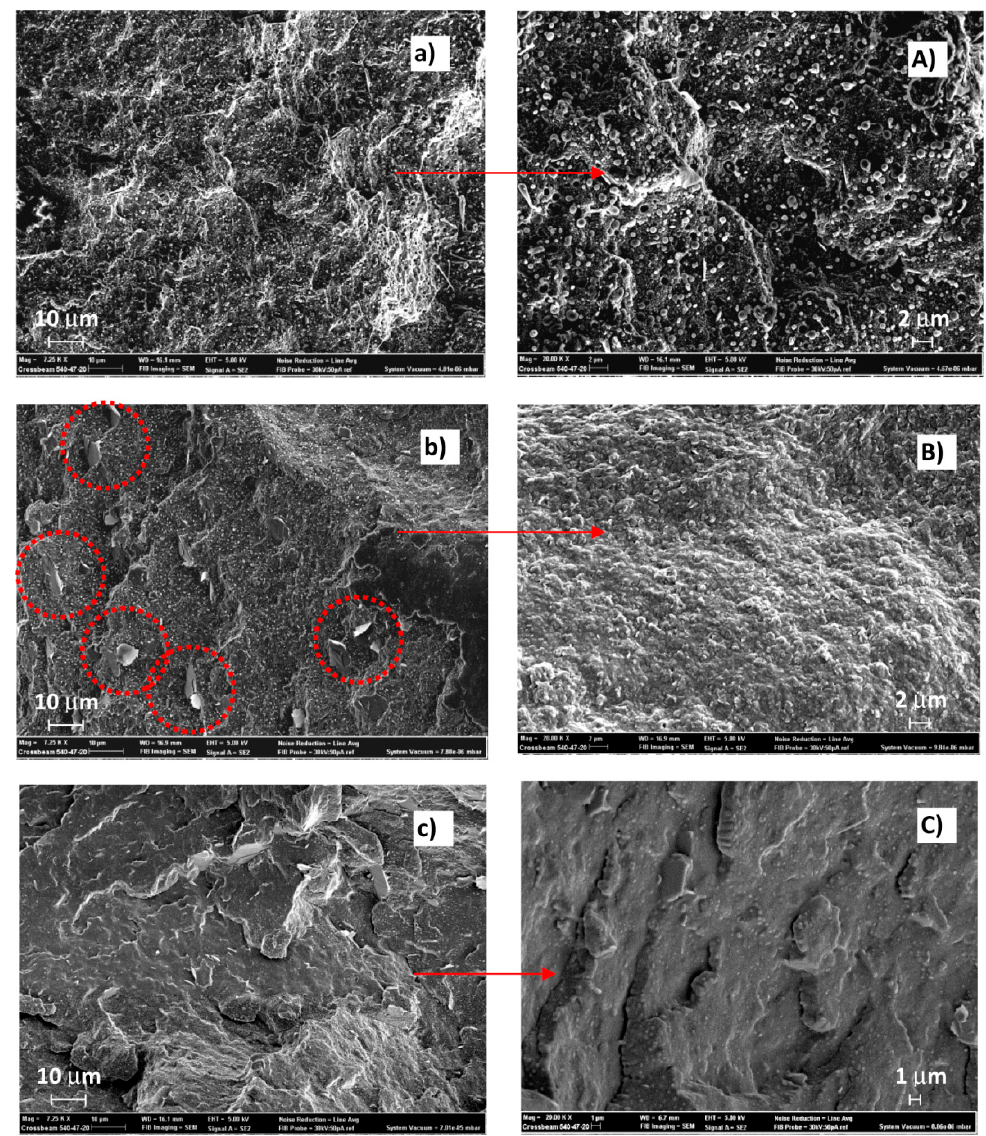
Figure 5. The images at 7250× (left) and at 20k× (right) of threads of EX ( a , A ), EXT1 ( b , B ), EXT5 ( c , C ).